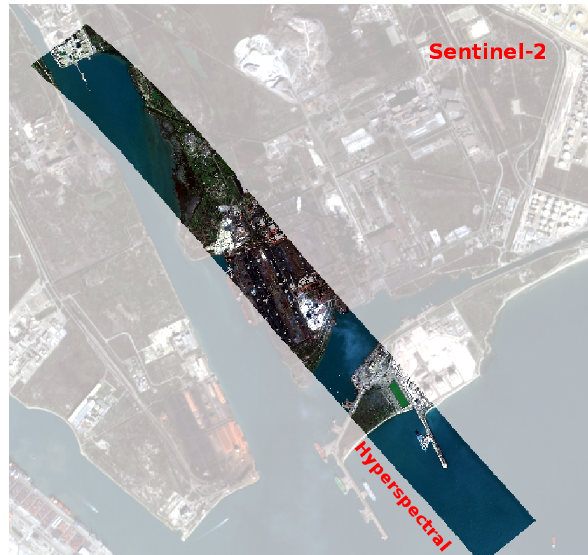
Figure 1. Hyspex hyperspectral image (opaque) superposed on the Sentinel-2 image